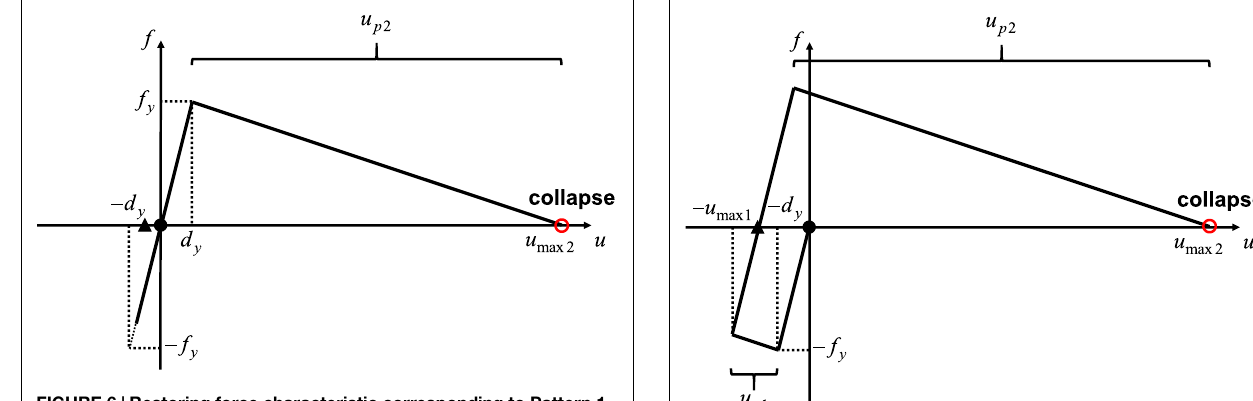
FIGURE 6 | Restoring force characteristic corresponding to Pattern 1 (Stability limit after the second impulse without plastic deformation after the first impulse) . FIGURE 7 | Restoring force characteristic corresponding to Pattern 2